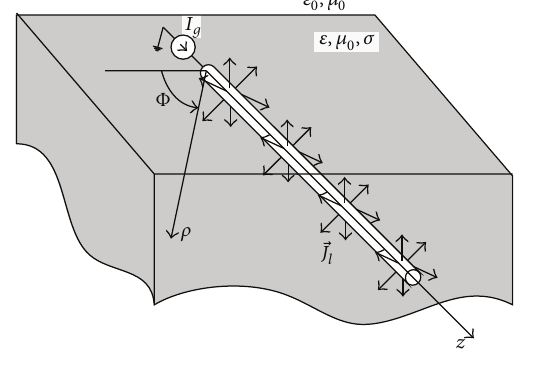
Figure 6: The leakage current density.